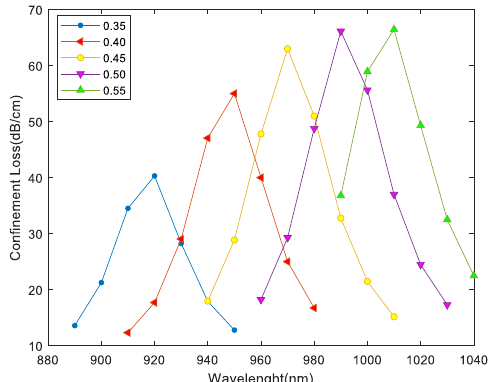
FIGURE 4. Confinement loss spectrum of the proposed sensor for analyte height variation of h a from 0.35 to 0.55 μ m. (d=2 μ m, d c =2.8 μ m, t Au =0.05 μ m, n a =1.48, n c